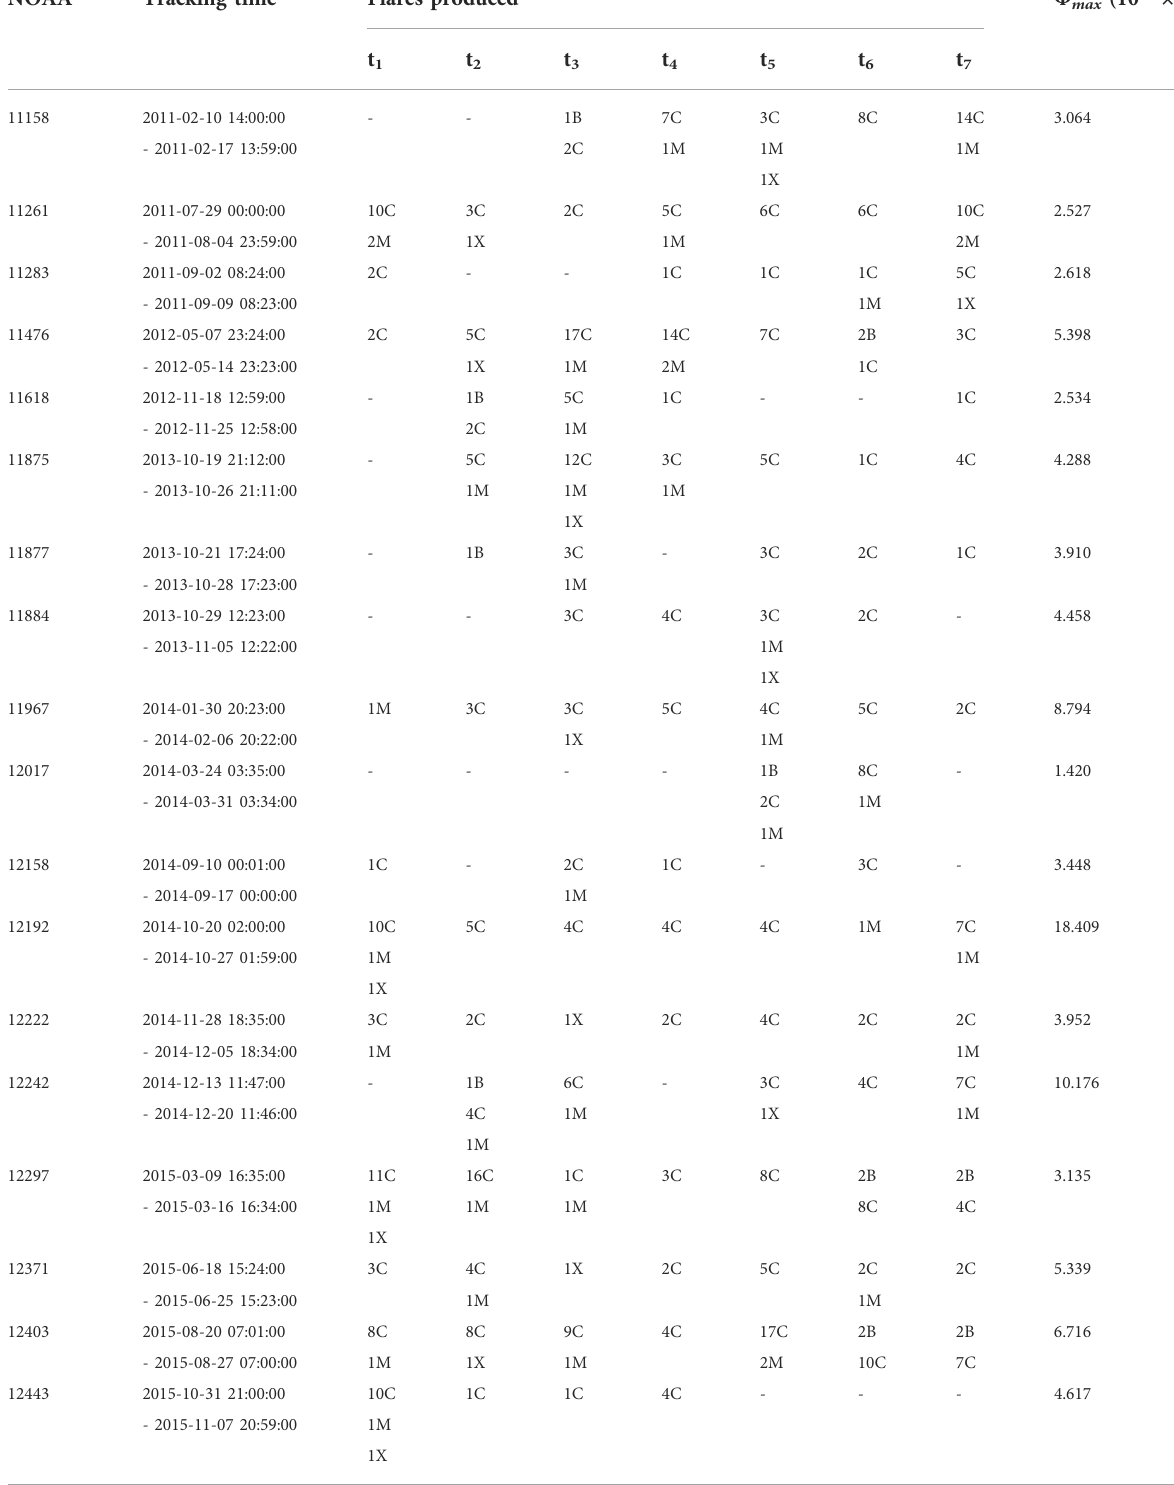
TABLE 1 NOAA number, tracking time, number of fl ares produced of each fl are class (B,C,M and X) and the maximum unsigned fl ux of the active regions during the tracking period. The columns t 1 − t 7 represents the 7 days of tracking. The number of fl ares corresponding to each fl are class are indicated as pre fi